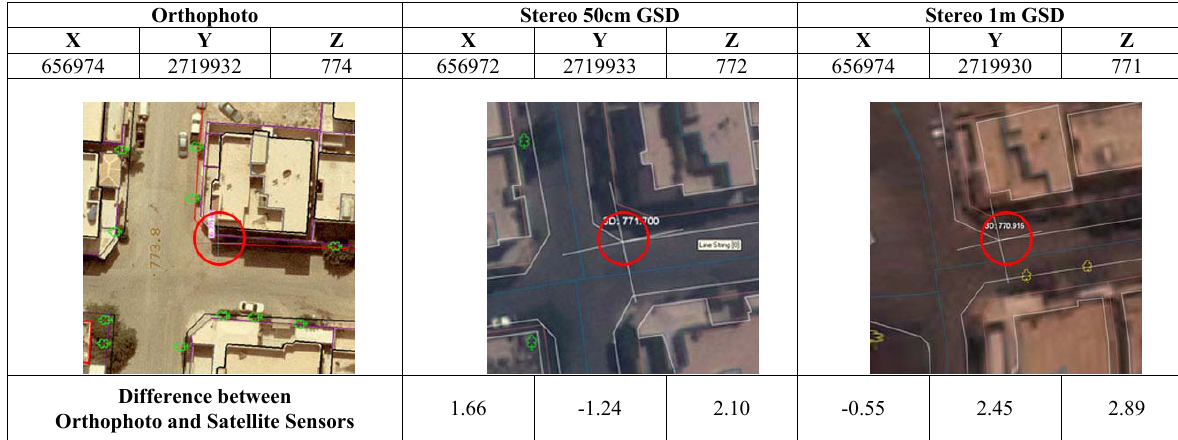
Table 1.b showing capturing of road corner based on different resolutions of Stereopairs.